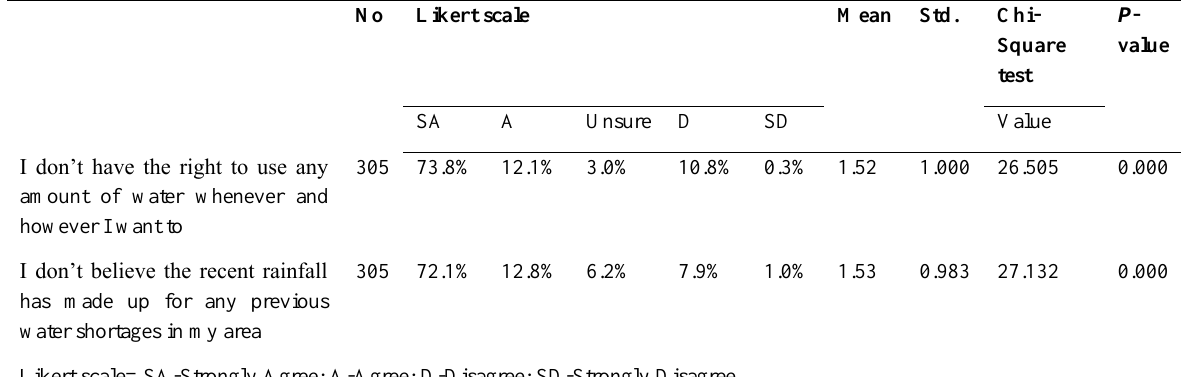
Table 4 : Respondents attitude towards water conservation